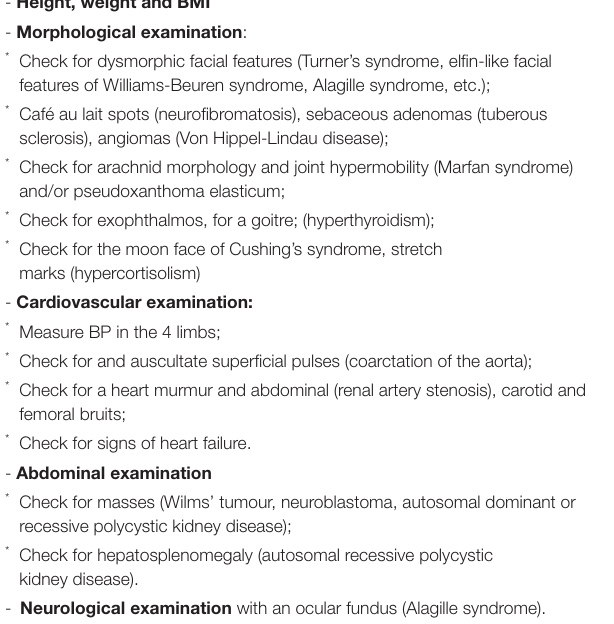
TABLE 3 | Clinical examination in a child or adolescent with elevated blood pressure or hypertension. - Height, weight and BMI - Morphological examination : * Check for dysmorphic facial features (Turner’s syndrome, elfin-like facial features of Williams-Beuren syndrome, Alagille syndrome, etc.);